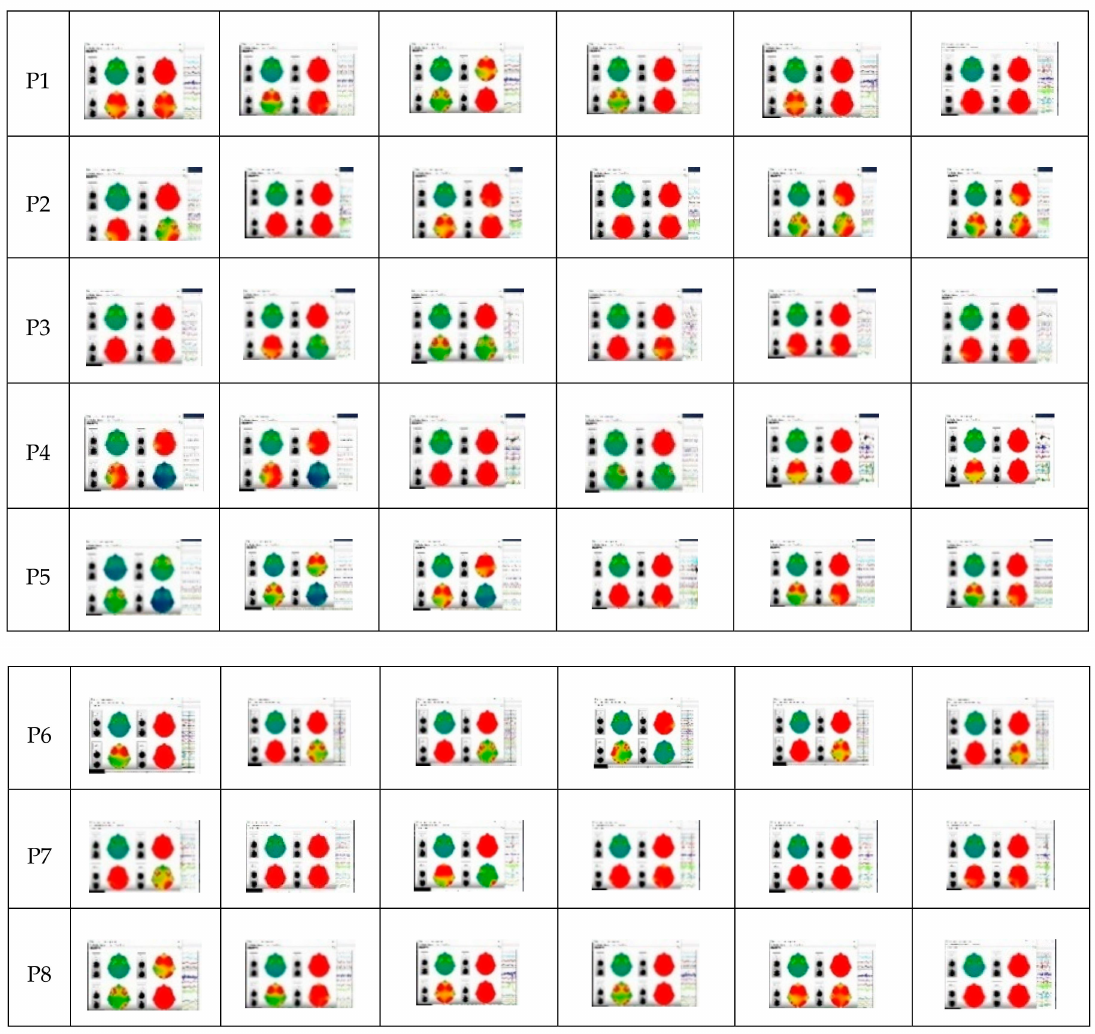
Figure 7. Brain activity sequences of eight participants in the “simultaneous” throwing condition. Each frame shows the delta (upper-left), theta (upper-right), alpha (bottom-left), and beta (bottom-right), oscillations of each moment. These frames, taken every two seconds, correspond to the central 12” of the